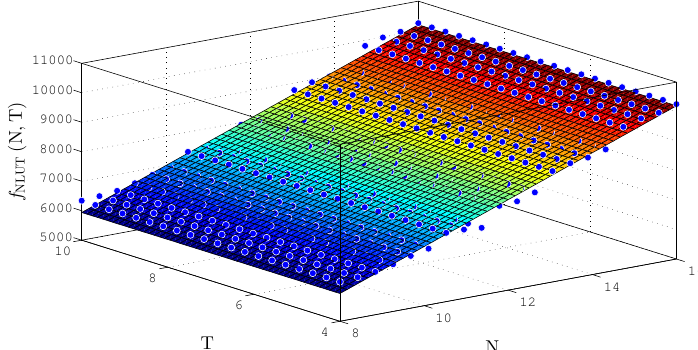
Figure 14. Plane, f NLUT ( N,T ) , found to estimate the number of LUTs as a function of the number of bits N and T for TS-FIMM-OS.